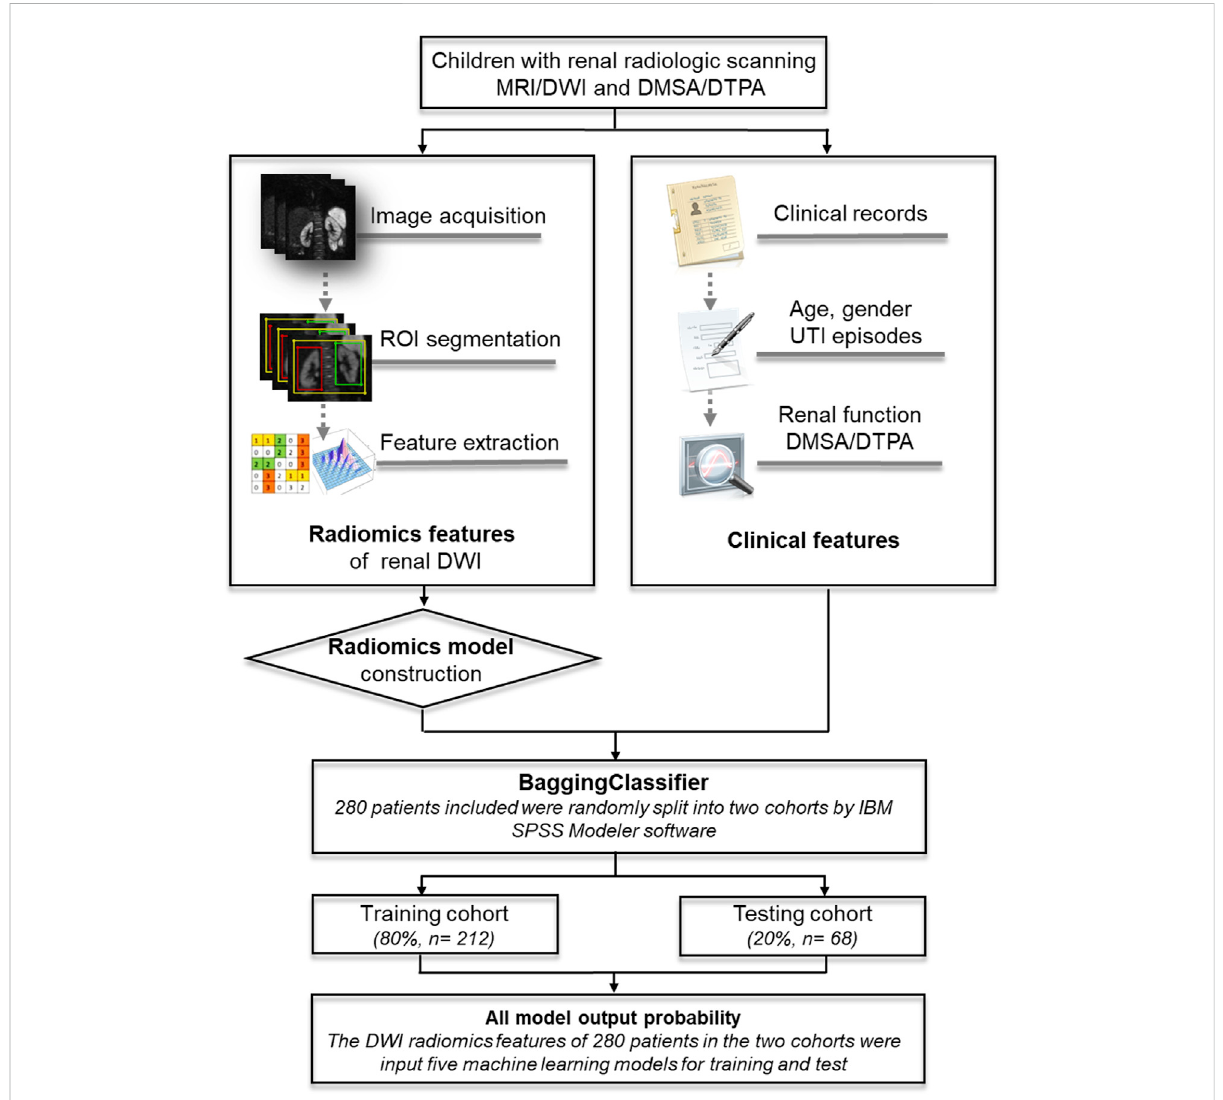
FIGURE 1 AnillustrationofthemachinelearningmodelsbasedonDWI-radiomicsinchildren.MRI,magneticresonanceimaging;DWI,Diffusionweighted imaging; DMSA, 99m Tc-labeled dimercaptosuccinic acid SPECT cortical renal scintigraphy; DTPA, 99m Tc-labeled diethylenetriamine pentaacetate renal